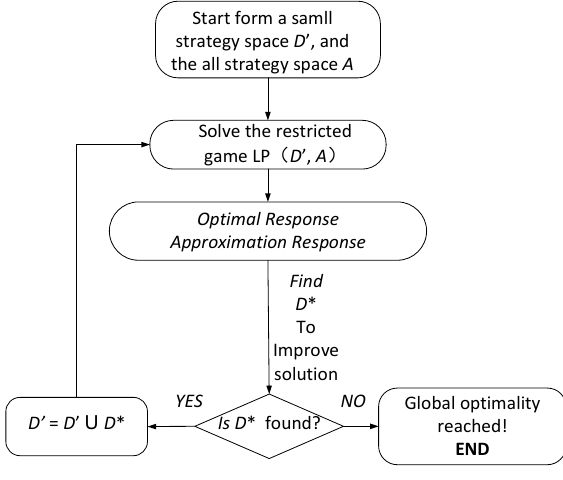
Figure 3. CG-AOD Framework